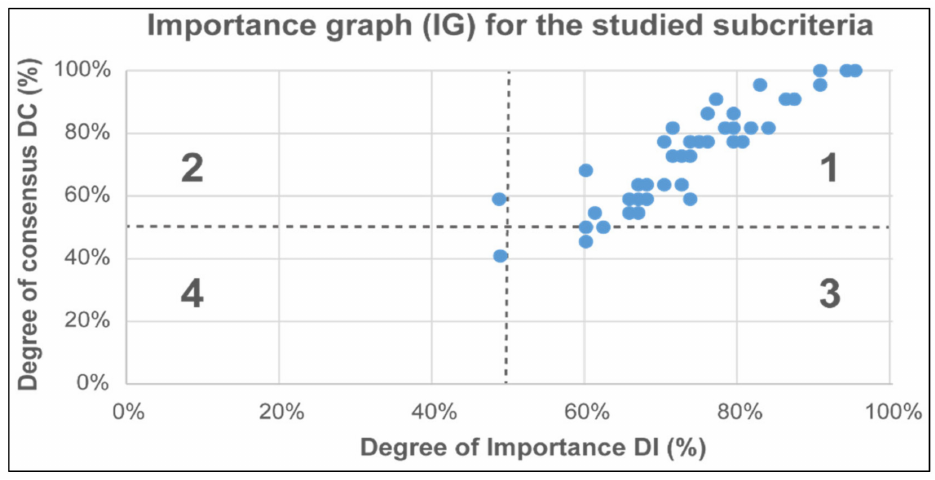
Figure 1. Dispersion graph showing the DI/DC relationship of all criteria analysed (Q1 to Q50). Area 1: DI > 50% and DC > 50%, Area 2: DI < 50% and DC > 50%, Area 3: DI > 50% and DC < 50%, Area 4: DI < 50% and DC < 50%. Table 3. Results obtained both from the two areas of research (values out of 5) and from the blocks that comprise them after round two.